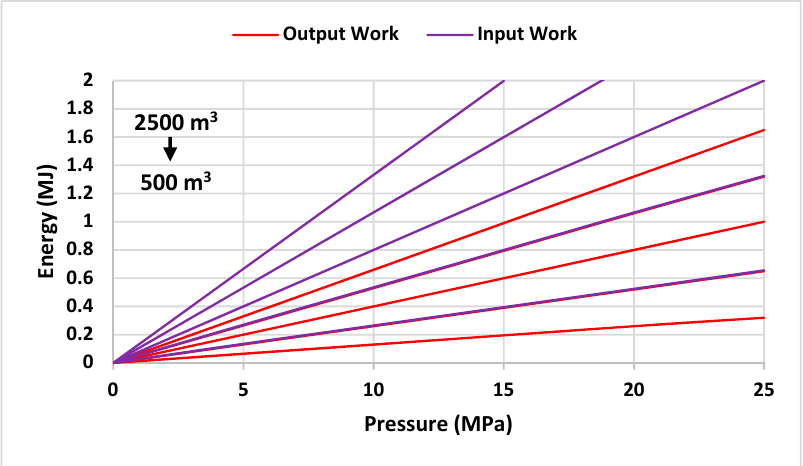
Figure 14. Changes in input and output work relative to pressure for α value equal to 0.25 for different tank volumes (from 2500 to 500 with steps of 500 m 3 ).